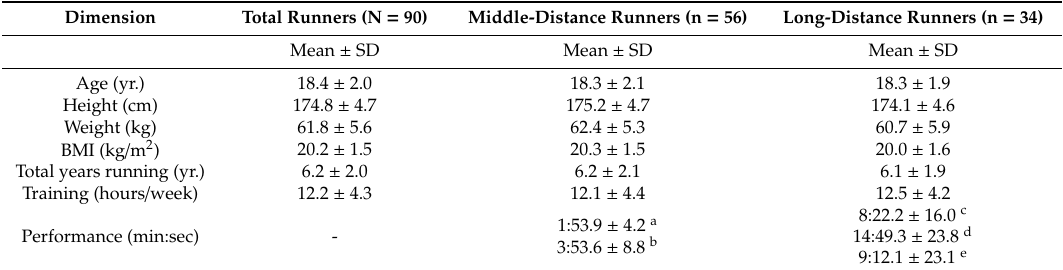
Table 1. Demographic characteristics of the study sample (mean ± SD) and di ff erences between middle-distance runners and long-distance runners.